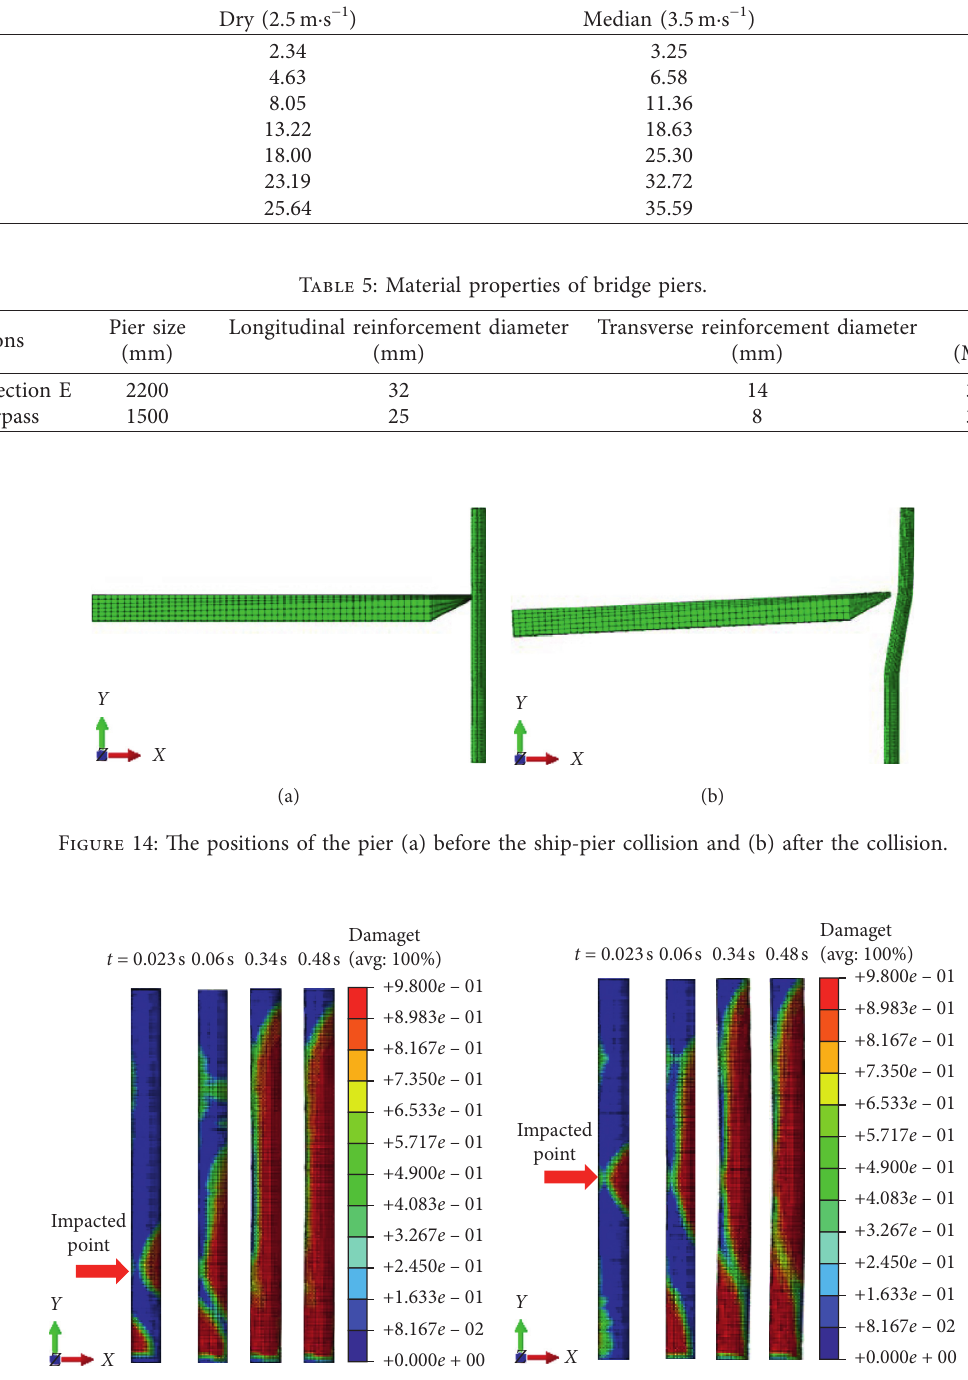
Figure 15: Tensile damage of the impacted pier based on FEM